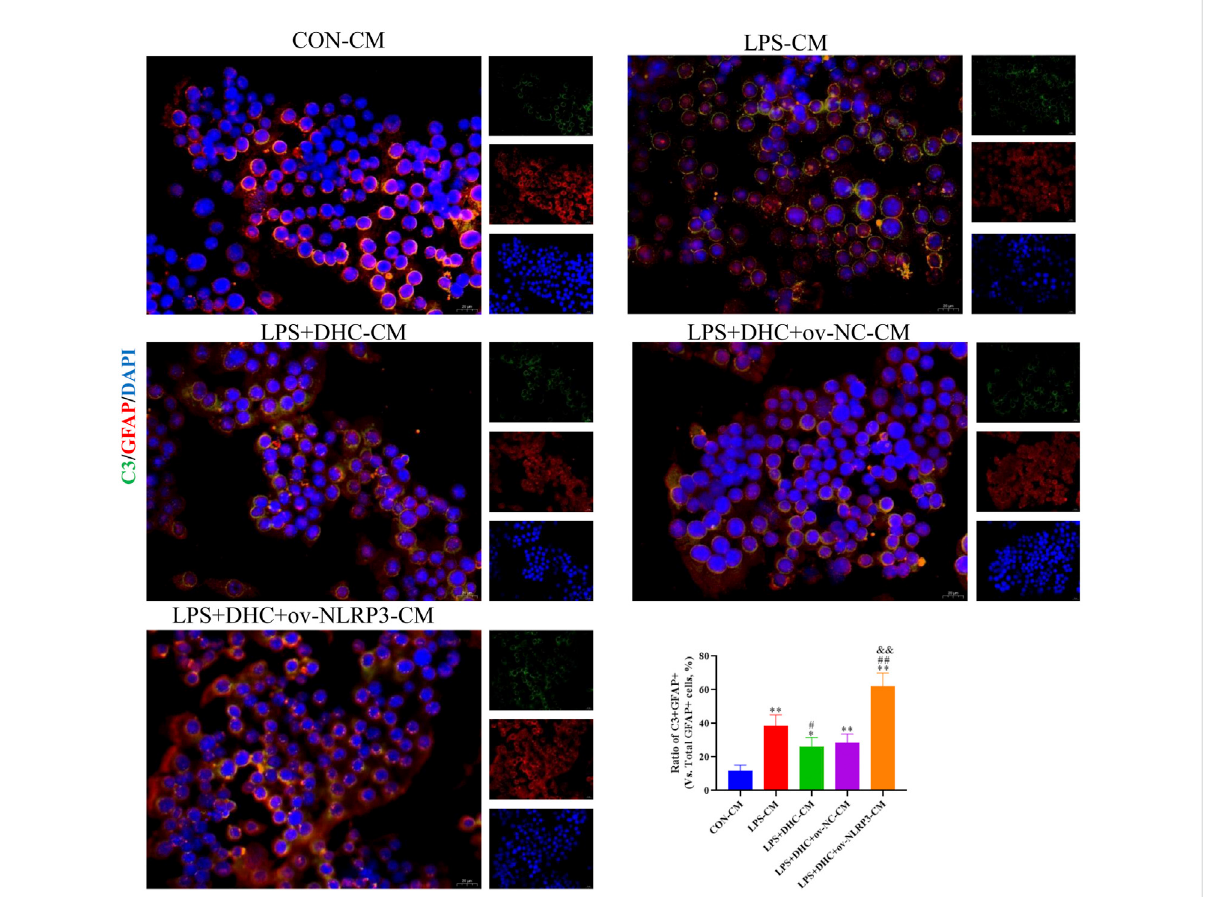
FIGURE 10 Effects of the microglia-conditioned medium on astrocyte activation. BV2 cells were incubated with DHC (100 mg/L) and 100 ng/ml LPS for 12 hov-NCorov-NLRP3plasmidwastransfectedintoBV2cells6 hbeforeLPSinduction.Conditioned mediaofmicrogliawerecollectedfromeach group,followedbyinterventionofastrocytesfor24 h.Theastrocytesweresubjectedtoimmuno fl uorescentstainingwithC3(green),GFAP(red),and DAPI (blue). * p < 0.05 and ** p < 0.01, comparedwith the control (CON) group; ## p < 0.01, compared with theLPS group; && p < 0.01, compared with the LPS + DHC